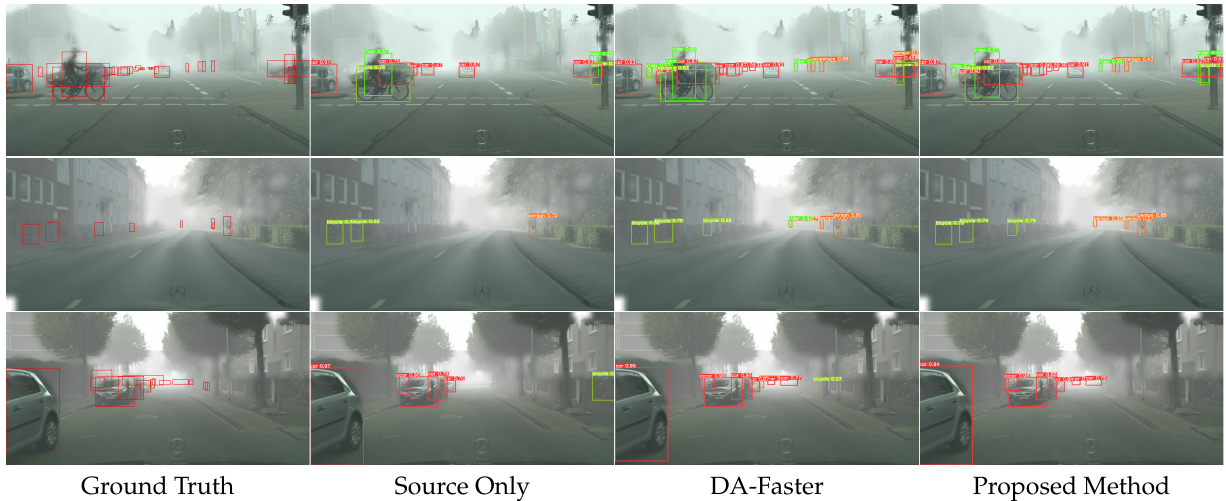
Source Only DA-Faster Proposed Method Figure 14. Qualitative results (Cityscapes → Foggy Cityscapes). The Cityscapes dataset is used as source domain, and the Foggy Cityscapes dataset is used as target domain. From left to right are the results from ground truth, source only, DA-Faster, and proposed